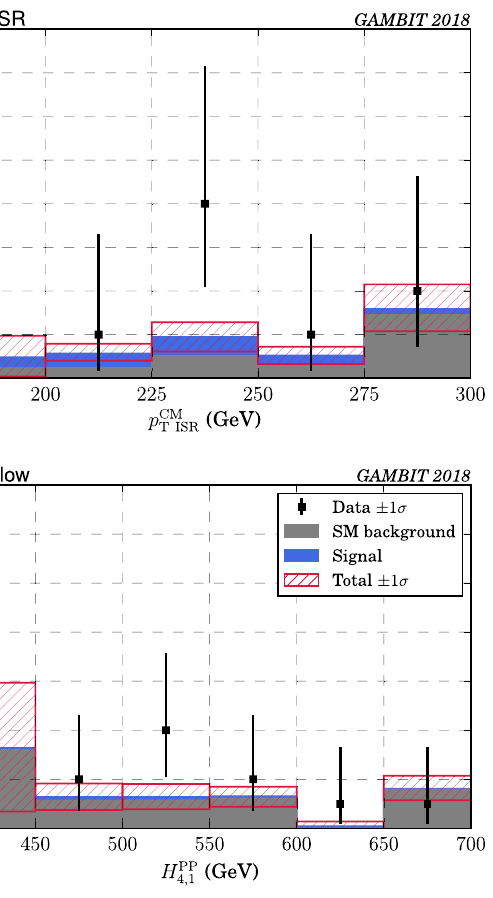
The hatched red bands show the 1 σ uncertainty on the total number of expected events, found by summing in quadrature the background uncertainty and the signal statistical uncertainty for our best-fit point. The black points show the ATLAS